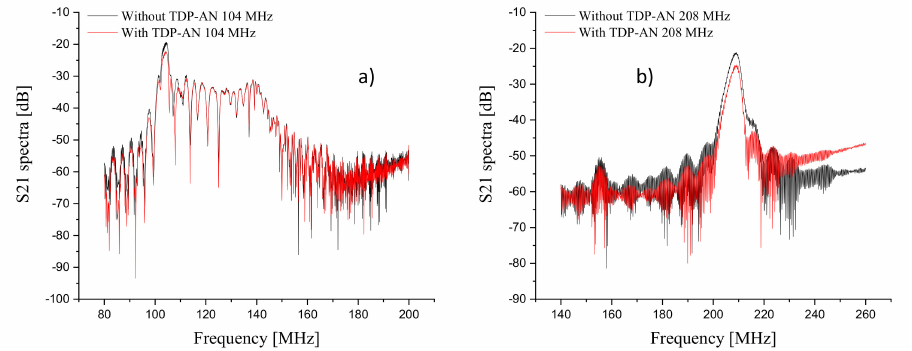
Figure 10. S21 spectra before and after the sensing area functionalization with TDP-AN molecule ( a ) for 104 MHz SAW; ( b ) for 208 MHz